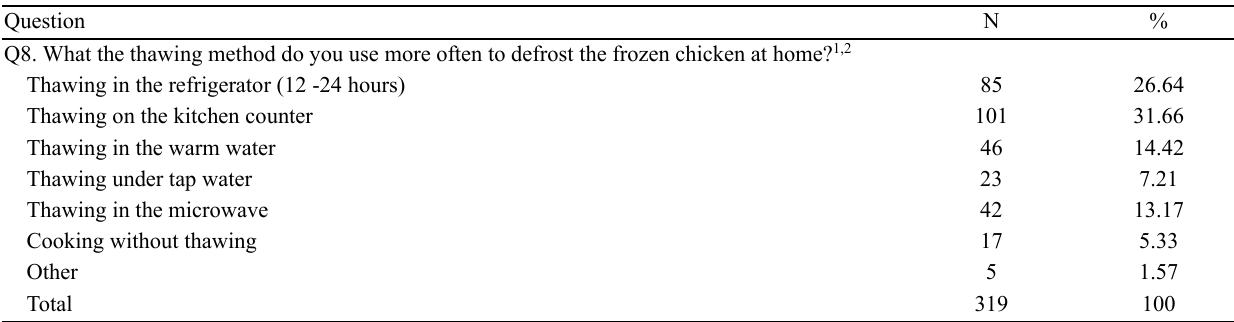
Table 4. Question to identify consumers’ thawing practices to defrost their frozen chicken meat before cooking Question N